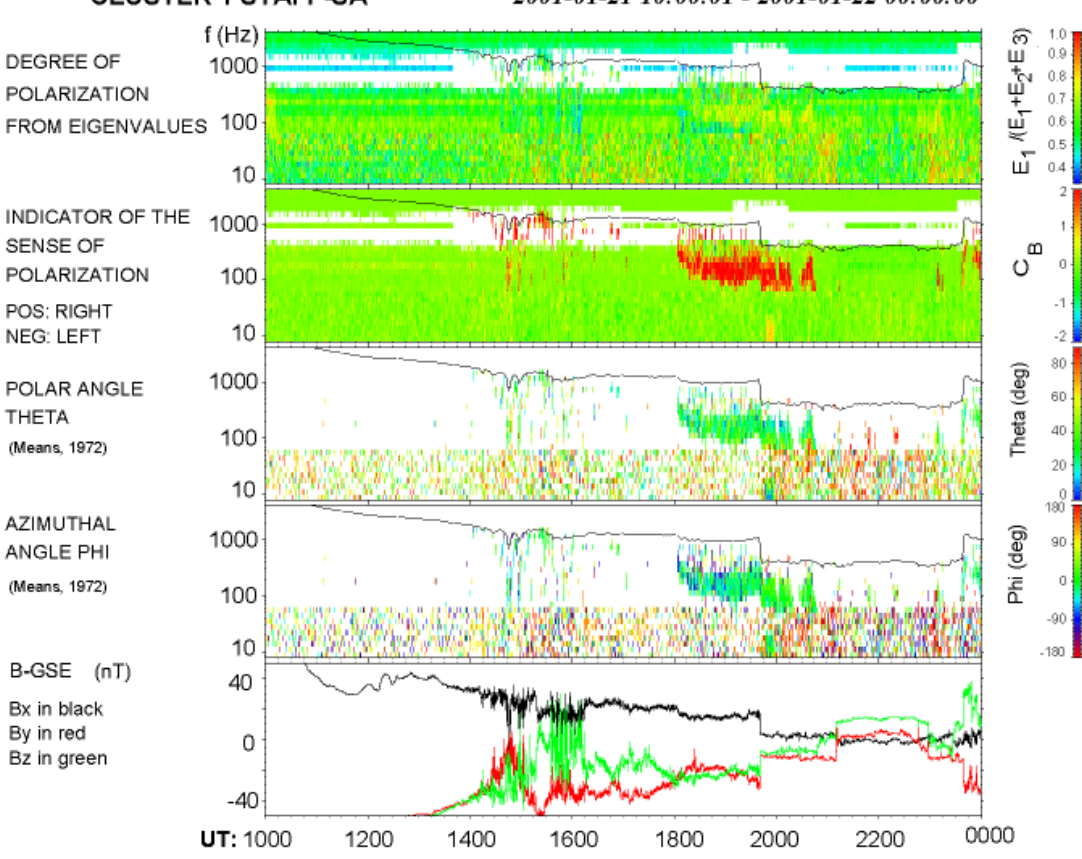
Fig. 5b. Characterisation of the waves for spacecraft 1 for the same time interval as in Fig. 5a. From top to bottom, the degree of polarisation, the sense of polarisation and the angles theta and phi values are colour coded, as indicated on the right hand side of the figure. The gyrofrequency is plotted in black. The bottom panel gives the 4s averaged magnetic field components from the FGM Prime Parameter data. The waves above 100Hz are clearly right